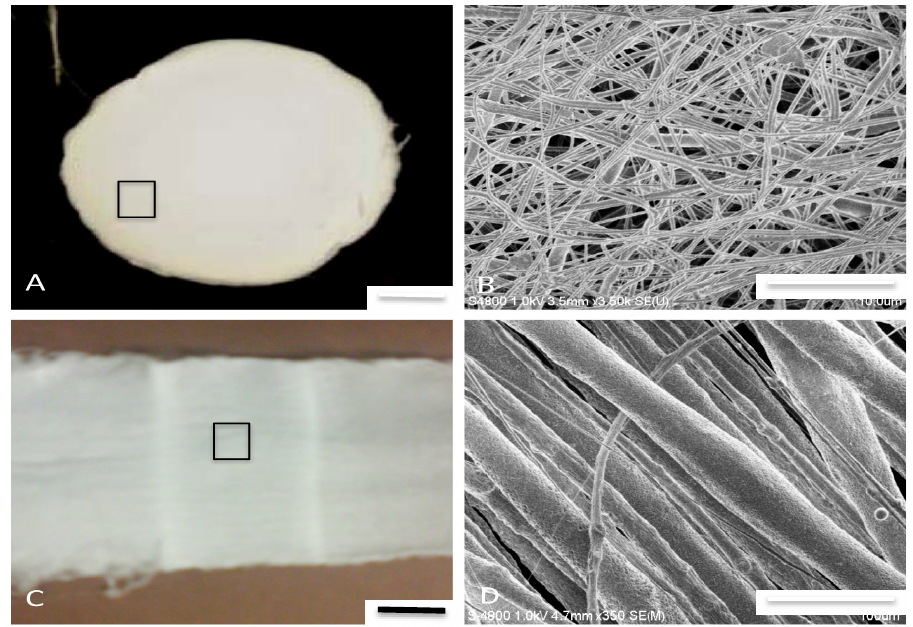
Figure 2. Fabricated PLC/Halloysite nanocomposites with 5% ( A , B ) and 7.5% HNTs ( C , D ). ( A ) Photograph of 5% HNT/PCL nanocomposite with a random fiber pattern. Area outlined by square shown under SEM microscopy in ( B ); ( B ) SEM image of 5% HNT/PCL nanocomposite, insert a single fiber at higher power; ( C ) 7.5% HNT/PCL nanocomposite with an oriented fiber pattern. Area outlined by square is shown at higher magnification in ( D ); ( D ) SEM image of 7.5% HNT/PCL nanocomposite, containing 5% HNTs in electrospun PCL. Note the PCL fibers have a defined orientation. Scale bars = 2 centimeters in ( A ) and ( C ), 10 microns in ( B ) and 100 microns in ( D ).